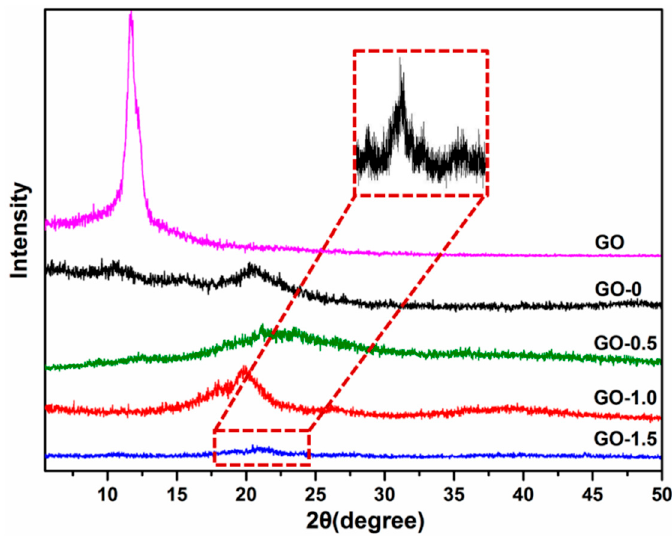
Figure 6. XRD patterns of GO and CSAs/GO aerogels with different GO contents. Table 3. The crystallinity of CSAs/GO aerogels with different GO contents. Samples